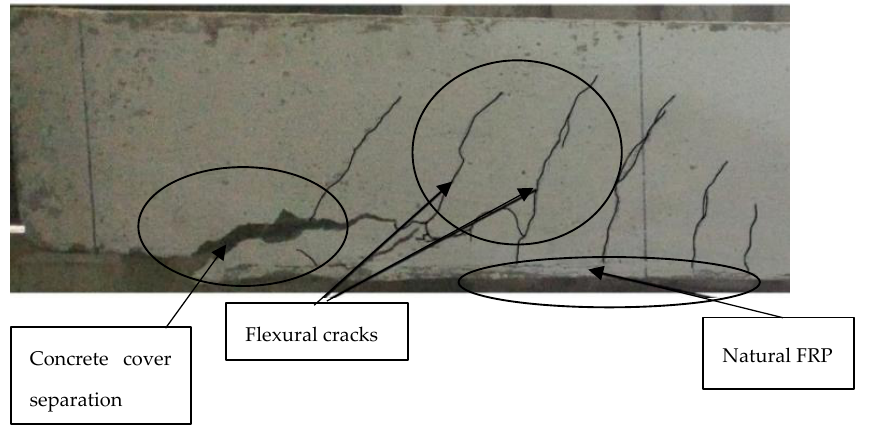
Figure 9. Failure mode showing concrete cover separation [16].